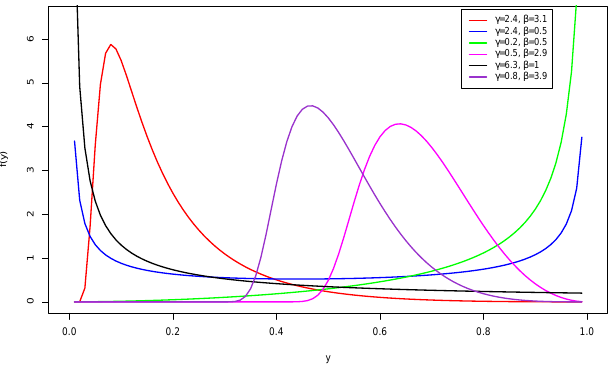
Figure 3. PDF plots of the TUGHN distribution. The corresponding QF is